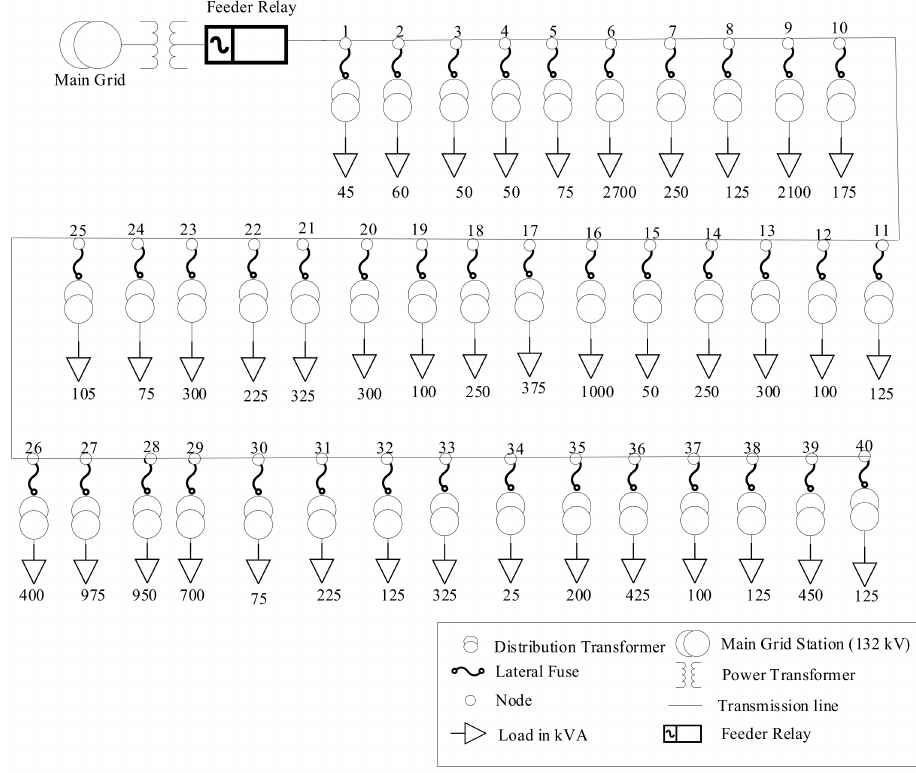
Figure 4. Simplified 40 points diagram of 11 kV